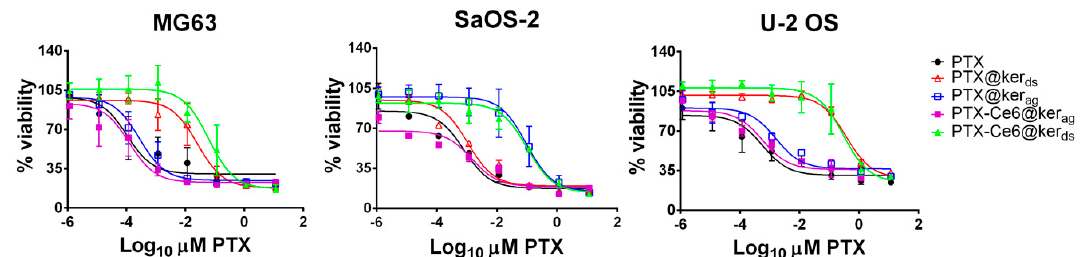
Figure 2. Sensitivity of osteosarcoma (OS) cell lines to free Paclitaxel (PTX), and PTX loaded onto keratin nanoparticles. The graphs show the WST-1 assay performed on OS cell lines exposed to PTX (black circles), PTX@ker ag (blue squares), PTX@ker ds (red triangles), PTX-Ce6@ker ag (pink squares), or PTX-Ce6@ker ds (green triangles). All results are expressed as the mean ± SD (from at least three independent experiments performed in triplicate).